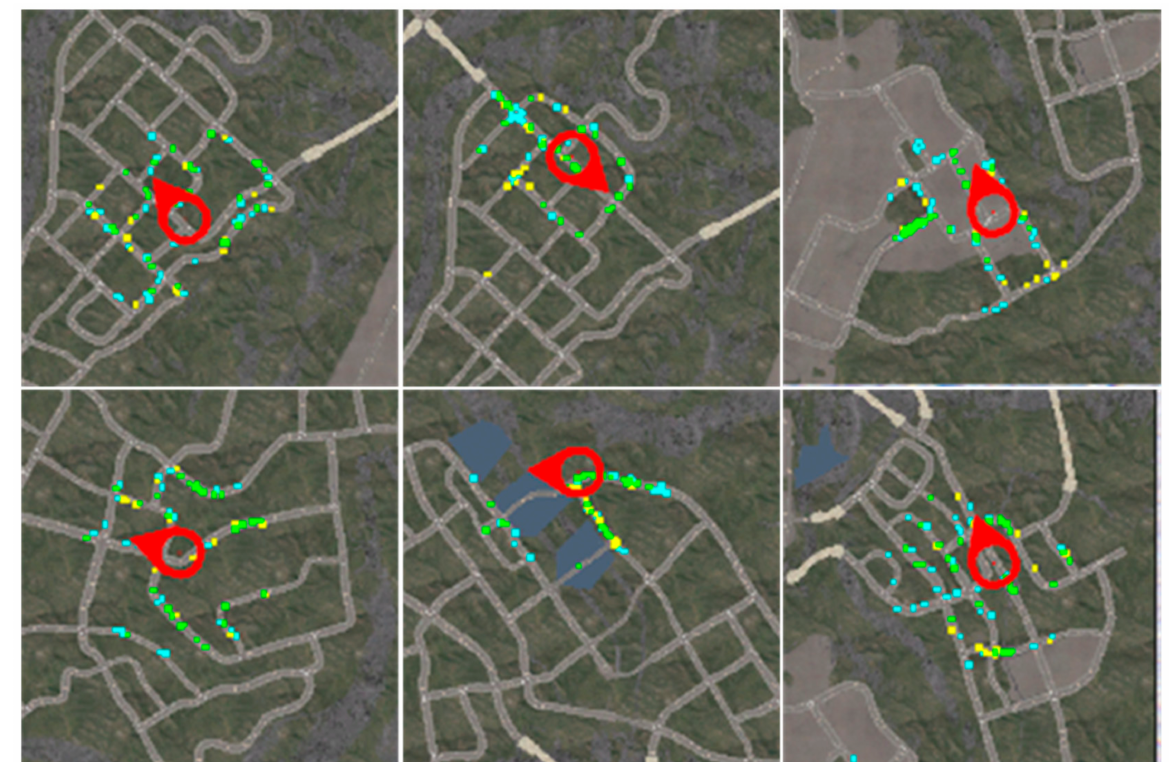
Figure 8. Distribution of agents in the normal mode. The red arrow represents the autonomous vehicle’s location and direction of movement, and the green, blue, yellow points represent vehicles, humans, and animals, respectively.